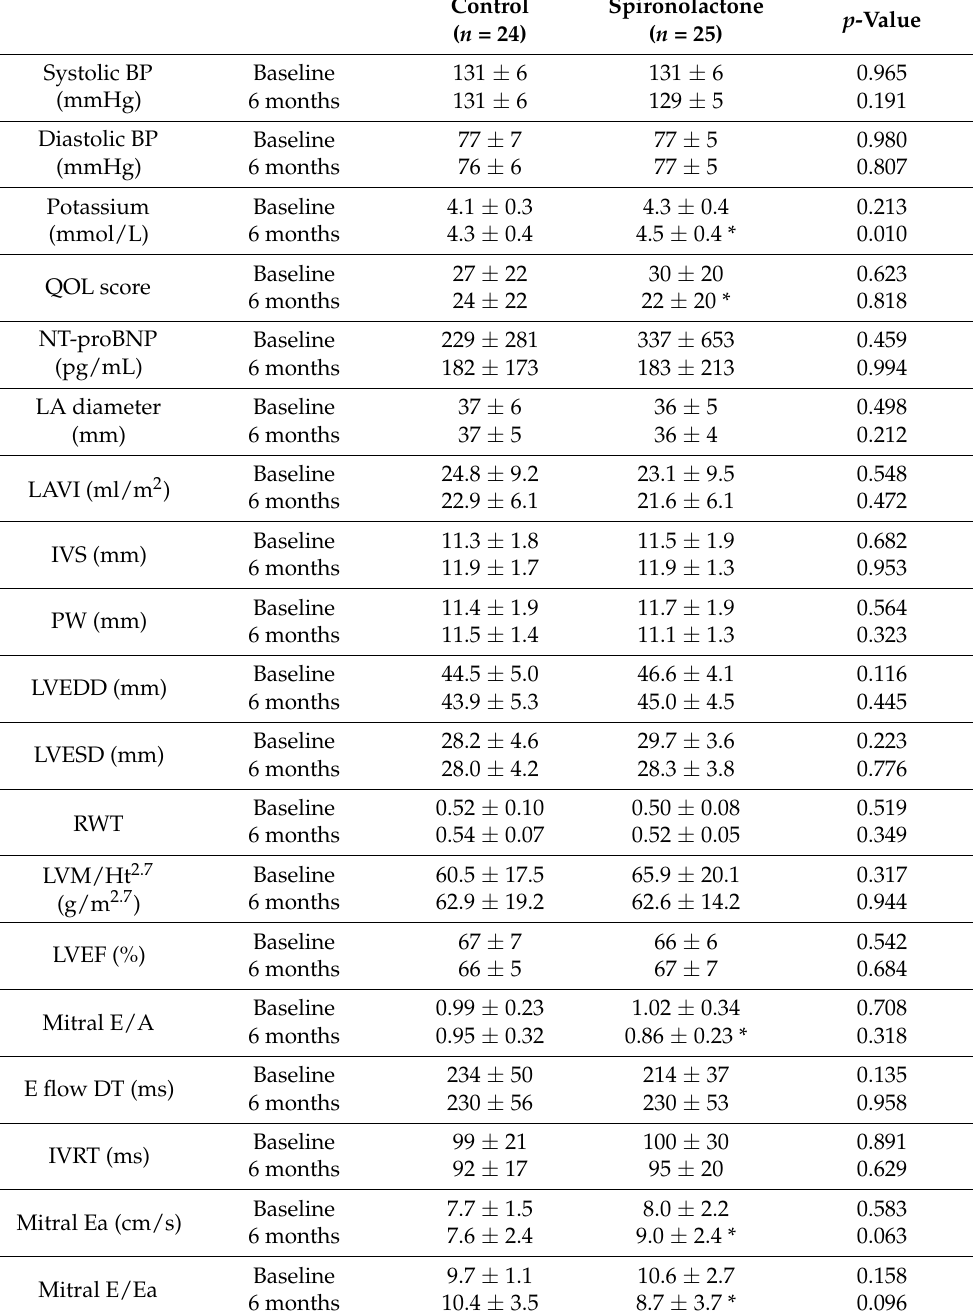
Table 2. Comparisons at baseline and 6